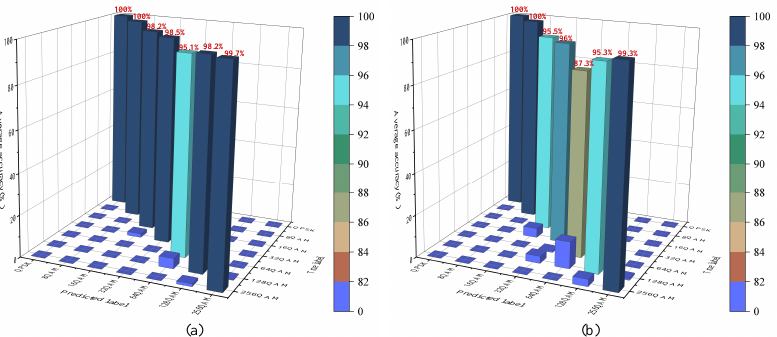
Figure 5. The average identification accuracy after 80 km fiber transmission ( a ) OSNR range is 0 ∼ 30 dB ( b ) OSNR range is 0 ∼ 10